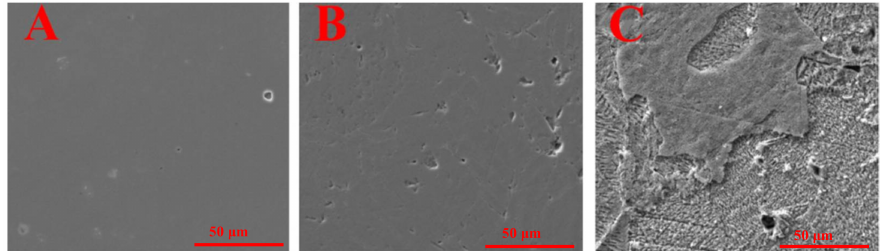
Figure 3. SEM images of chalcopyrite ( A ) without treatment; ( B ) treated at 0.87 V; and ( C ) treated at − 0.54